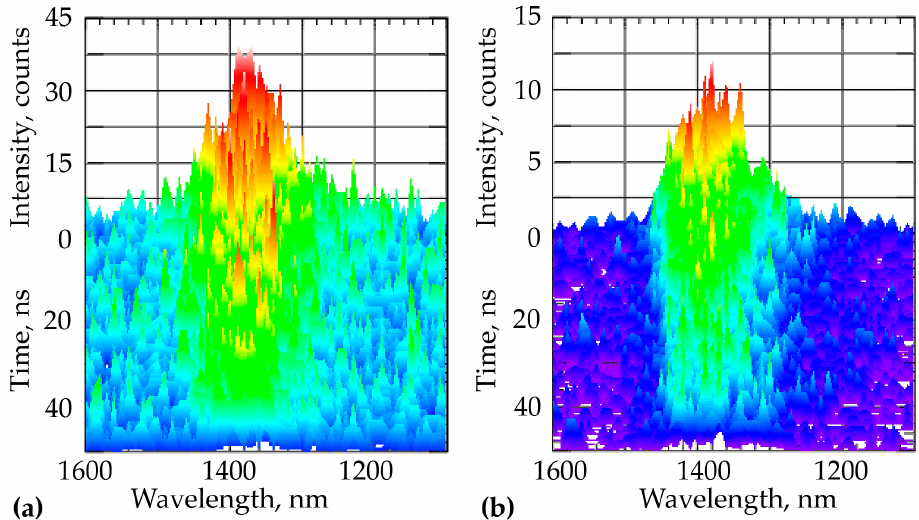
Figure 4. PL spectra of the InP/InAsP/InP NWs heterostructure: ( a ) at 1064 nm wavelength excitation and at T = 77 K: A is NWs; ( b ) is NWs with the TOPO-CdSe/ZnS QDs layers.